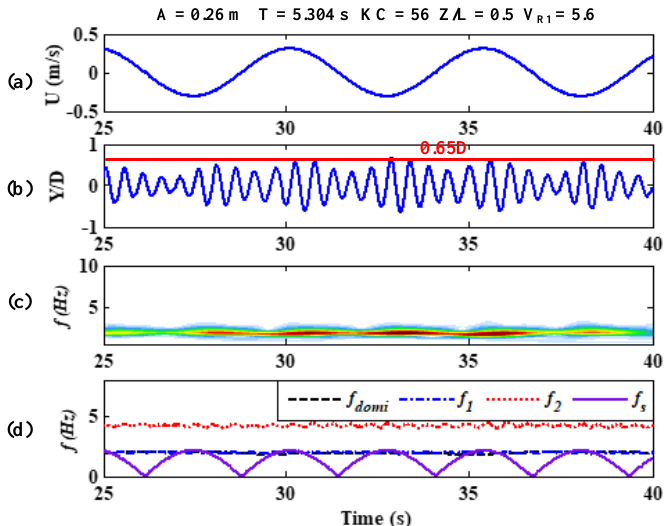
Figure 10. The time history of the VIV response and time–frequency distribution at Z/L = 0.5 for V R1 = 5.6 and KC = 56: ( a ) The forced motion velocity; ( b ) The VIV displacement response; ( c ) The time–frequency distribution of the VIV response; ( d ) The time-varying frequencies.